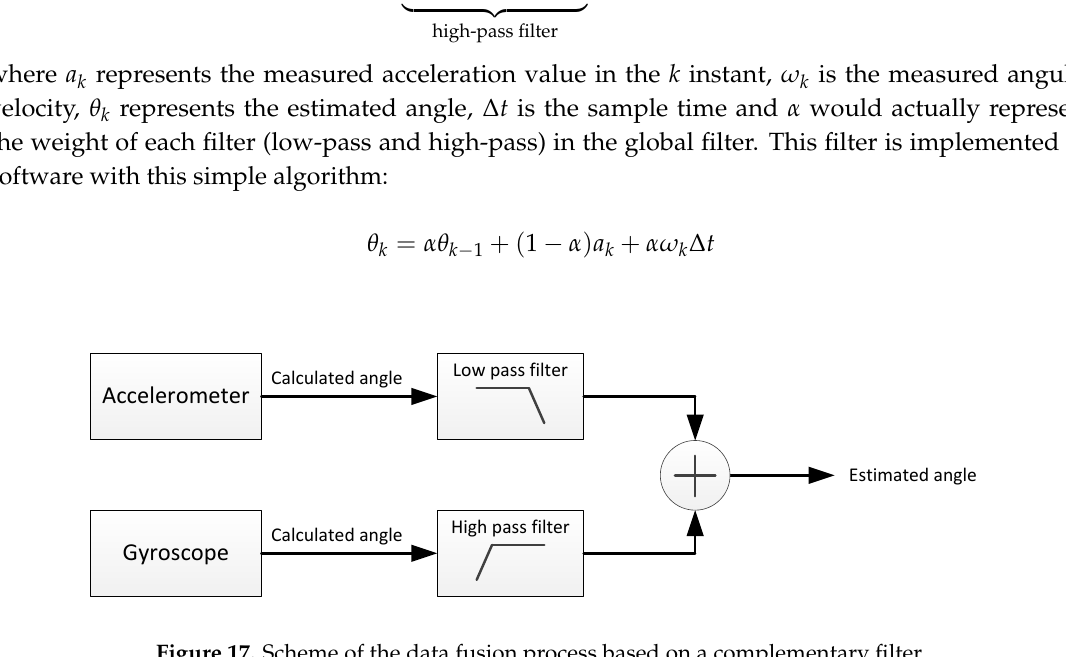
Figure 17. Scheme of the data fusion process based on a complementary